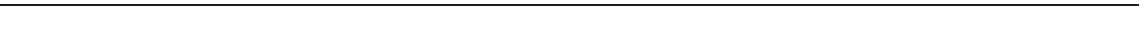
Fig. 4 VEGFR is an upstream regulator of Hippo signaling. VEGFR inhibition activates LATS-BS a and suppresses YAP/TAZ transcriptional co-activation in HEK293A b . Cells were treated with each inhibitor for 4 h at 10 μ M ( n = 3). c VEGFR inhibition diminishes expression of YAP/TAZ targets, CYR61/CTGF . HEK293A were treated with inhibitors for 4 h at 10 μ M. CYR61 or CTGF mRNA expression was determined by qRT-PCR ( n = 3). d VEGFR reduces YAP- S127 phosphorylation in HEK293 (western blotting). e VEGF stimulation inhibits LATS-BS activity in MCF10A stably overexpressing VEGFR1/2. MCF10A- VEGFR1/2 were transfected with LATS-BS. Cells were treated with VEGF (100 ng ml − 1 ) for the indicated times. For some samples, cells were pre-treated with axitinib at 10 μ M for 3 h before VEGF treatment ( n = 3). f , g VEGF increases YAP/TAZ transcriptional co-activation of CYR61 in MCF10A-VEGFR1/2 ( f ), as well as in BOEC and MDA-MB231 ( g ). Cells were treated with 100 ng ml − 1 VEGF for the indicated times. CYR61 expression was measured by qRT- PCR. For some samples, cells were pre-treated with Axitinib at 10 μ M for 3 h before VEGF treatment ( n = 3). h - m VEGF stimulation increases YAP/TAZ shown after treatment with 100 ng ml − 1 VEGF for the indicated times. Scale bar represents 15 μ m. i , k , m YAP/TAZ subcellular localization was quanti fi ed in three separate experiments in which at least 200 cells were examined. n , o VEGFR2 signals through PI3K, AKT, and MEK to inhibit LATS-BS ( n ) and activate the STBS reporter ( o ). Cells were untreated or treated with VEGFR inhibitor (axitinib), PI3K inhibitor (LY294002), AKT inhibitor (triciribine), or